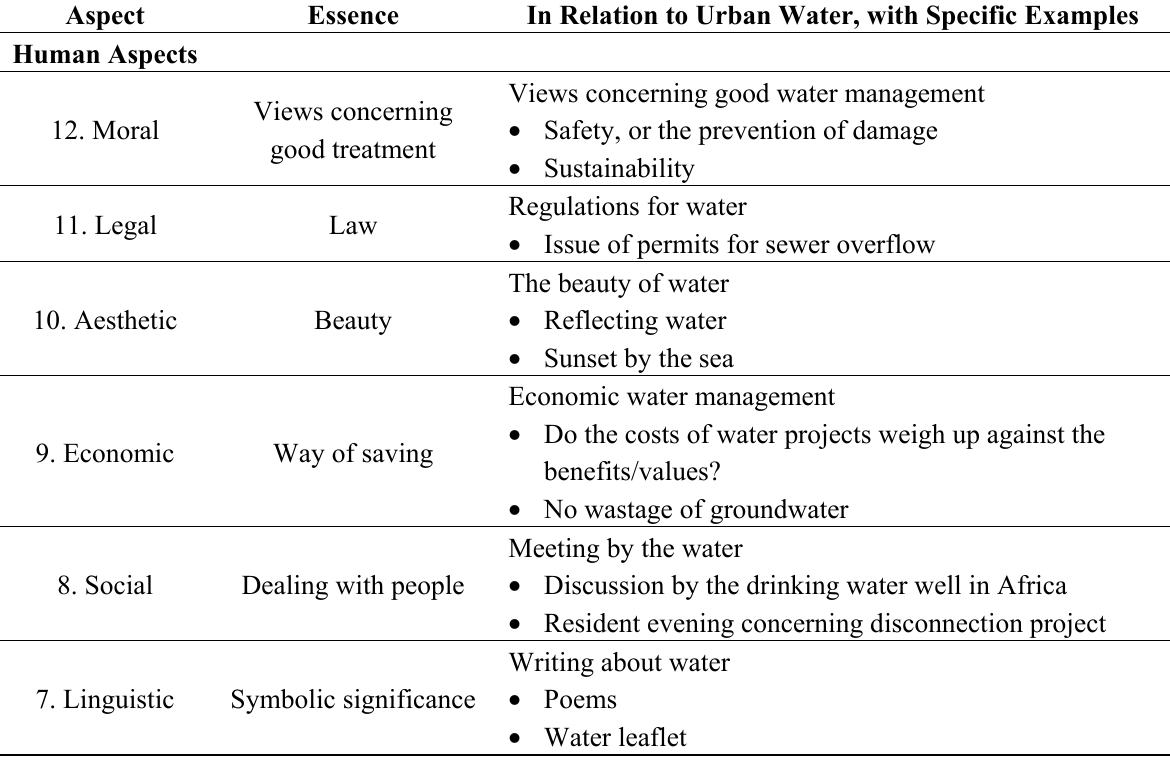
Table 1. The 12 aspects of water used in our analysis, adapted from Valkman et al. [10]. Aspect Essence In Relation to Urban Water, with Specific